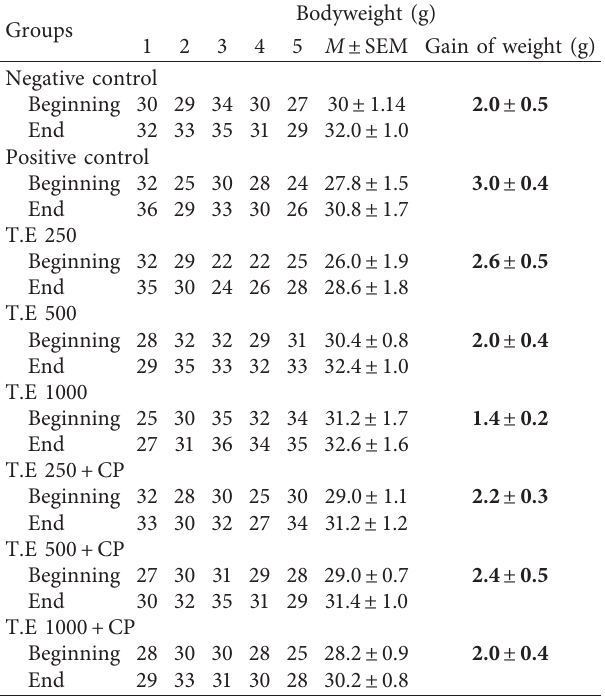
Table 1: Effect of total extract on bodyweight of